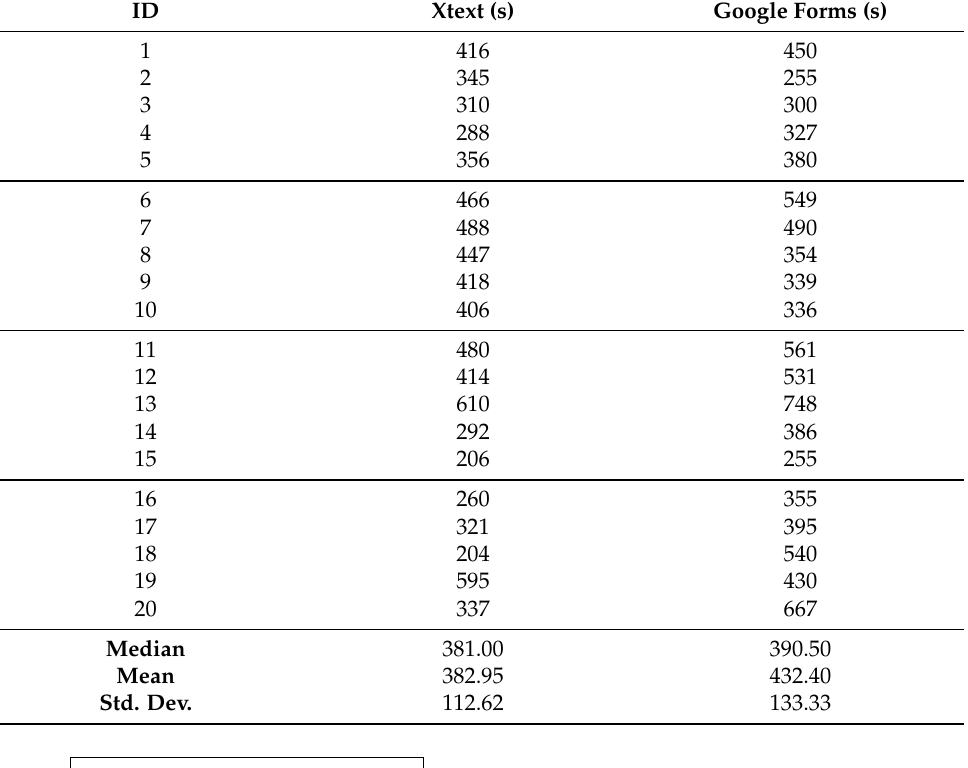
Table 1. Results of the XText vs. Google Forms experiment.